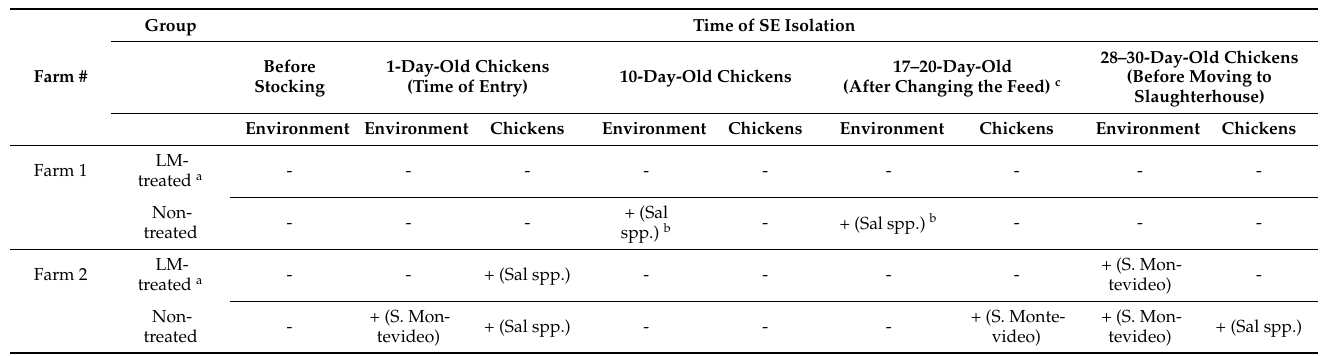
Table 3. Application of the LAB mixture in an actual farm setting and SE isolation from the farm environment and